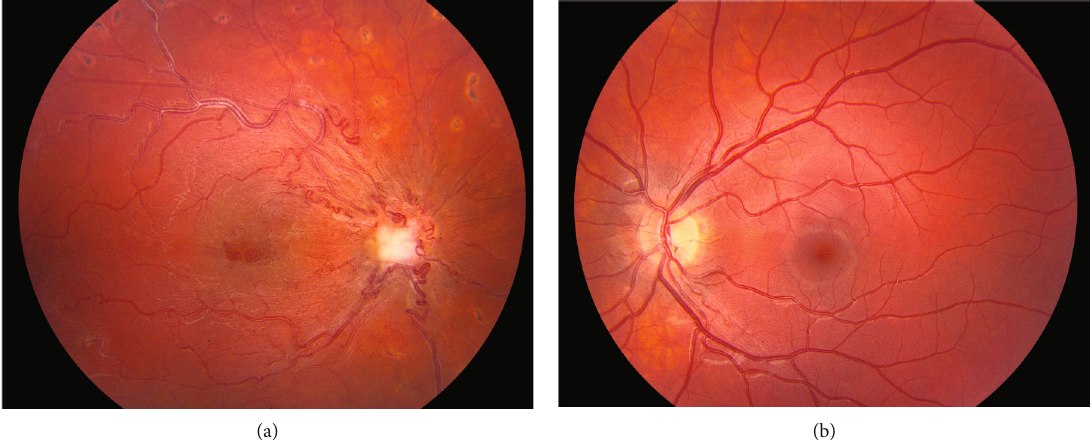
Figure 1: (a) Fundus of the a ff ected right eye of patient postsurgery, showing enlarged and tortuous vessels extending from the optic disc. A fi brous tuft is visible at the optic disc. (b) Normal fundus of the left